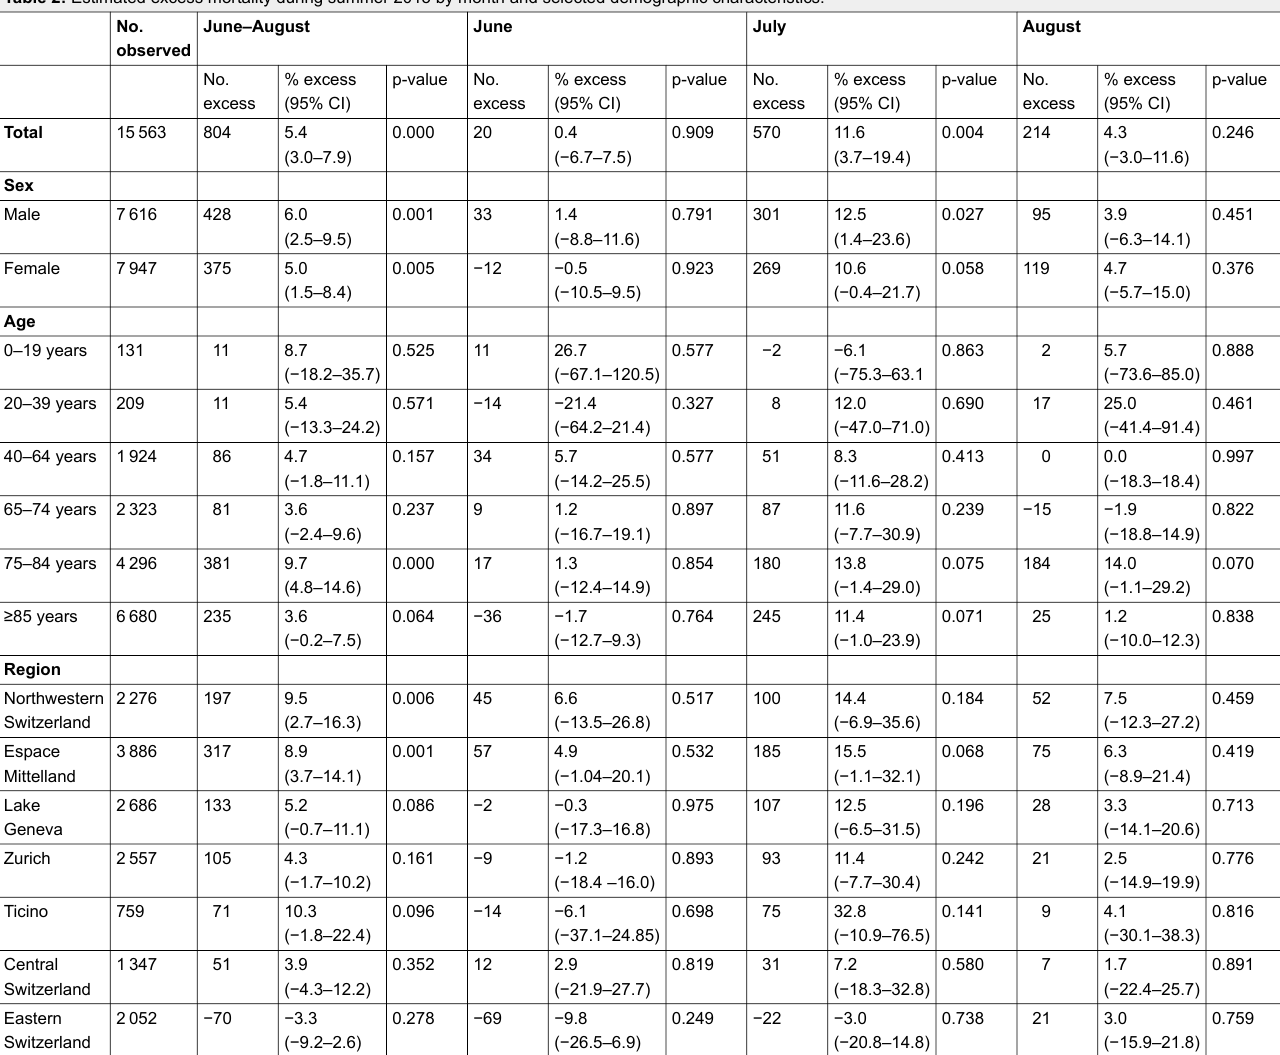
Table 2: Estimated excess mortality during summer 2015 by month and selected demographic